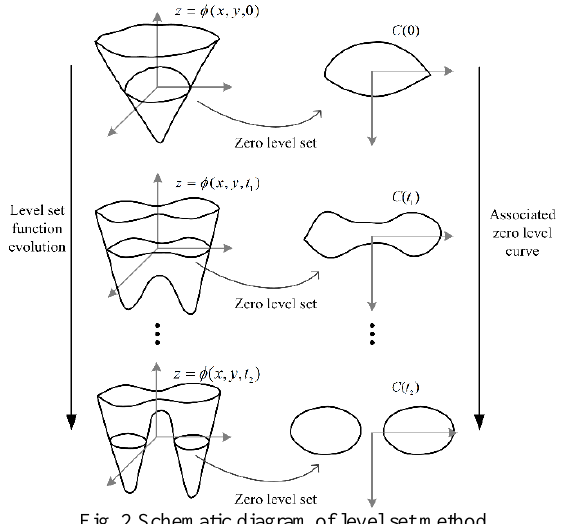
Fig. 2 Schematic diagram of level set